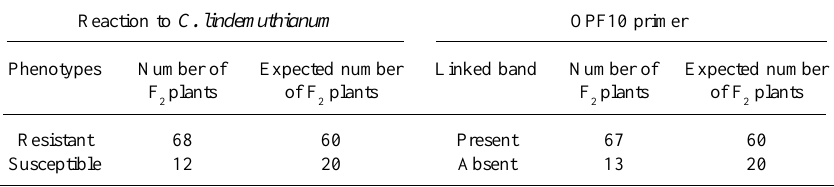
Table III - Number of F bean plants with phenotypes resistant or susceptible to Colletotrichum 2 lindemuthianum, and the occurrence of a linked band produced by primer OPF10, for the cross Carioca 300V x